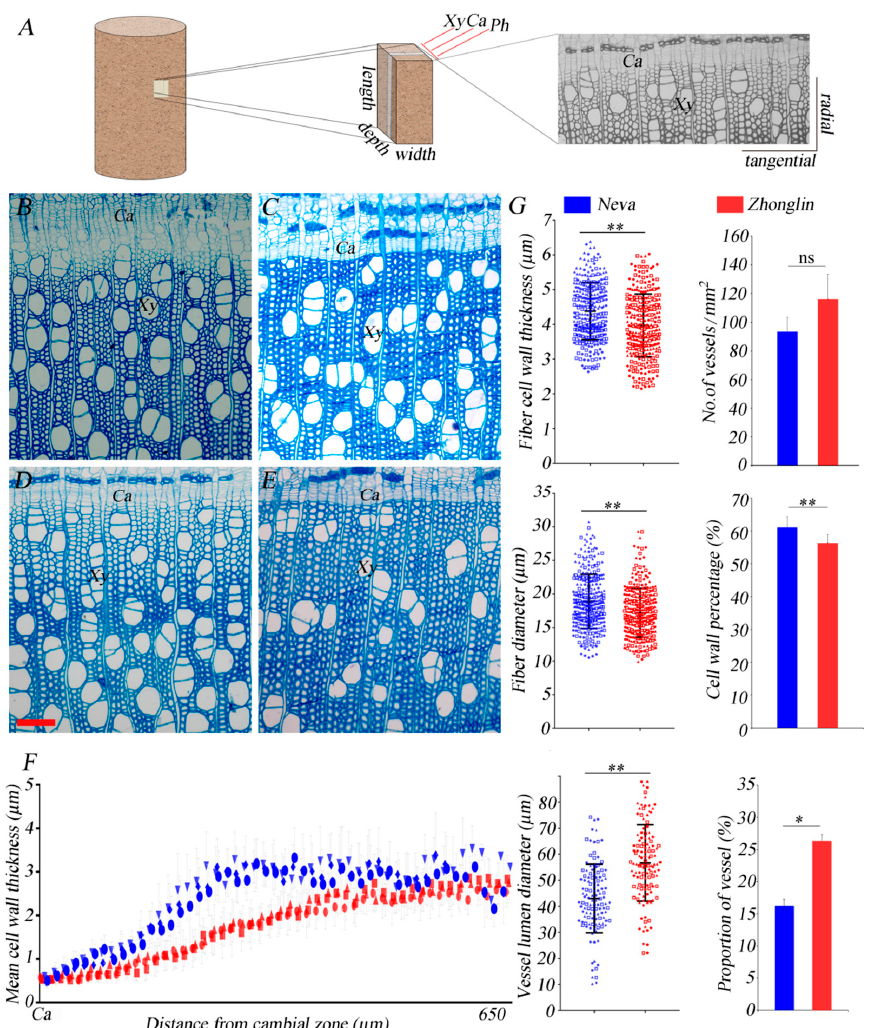
Figure 1. Microscopic analysis of stems from two black poplar cultivars. ( A ) A schematic overview showing the directions of the sample blocks and the stem cross-sections. ( B , C ) Cross-sections of phloem–xylem region from P. euramericana ‘Zhonglin46’ sampled on 4 July ( B ) and December 19 ( C ). ( D , E ) Cross-sections of phloem–xylem region from P. euramericana ‘Neva’ sampled on 4 July ( D ) and December 19 ( E ). Scale bar = 100 µm. ( F ) Changes in thickness of fiber cell wall during cell wall maturation. ( G ) Anatomical characteristics of the two poplar cultivars. *, p < 0.05; **, p < 0.01; ns, not significant. The triangle, rectangle, and circle represent different biological repetitions. Neva is shown in blue and Zhonglin46 is shown in red. Ph: phloem, Ca: cambium, Xy: xylem.